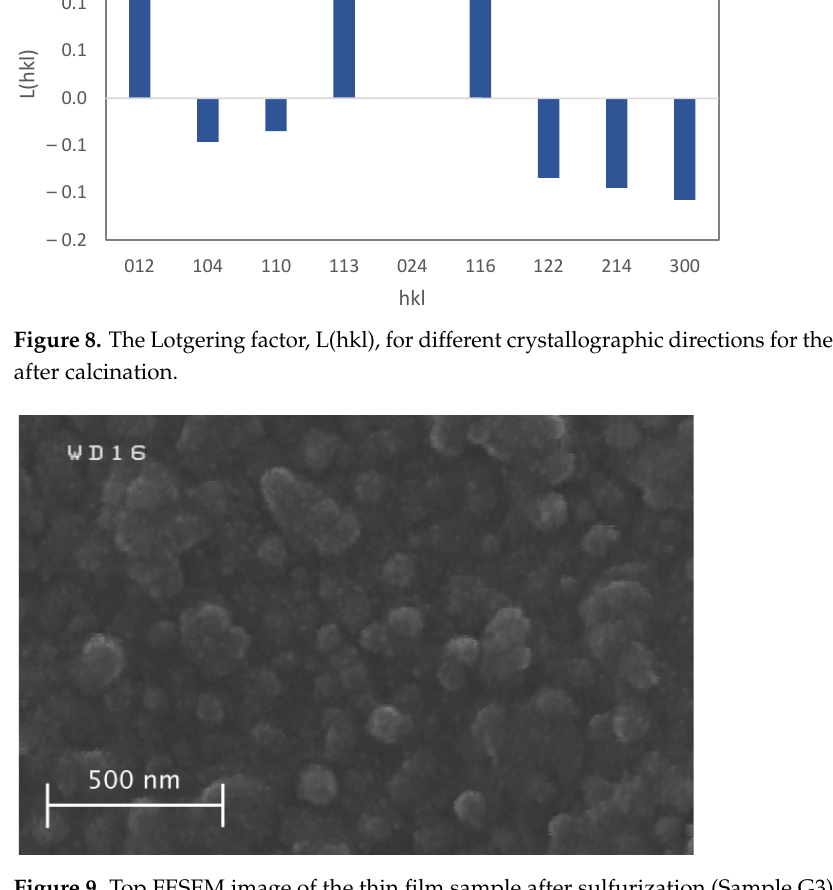
Figure 10 . The SEM Image of the cross ‐ section of pyrite thin film on FTO. The thickness of the two layers, FTO and pyrite, is compared by dashed arrows. The black arrow shows some impurities which are deposited on the surface of the thin film. Figure 11 . ( a ) The XRD pattern of pyrite powder sample with simulated patterns of reference cards of ( b ) pyrite (JCPDS 3 ‐ 065 ‐ 1211) and ( c ) hematite (JCPDS 33 ‐ 0664). (1 ̅ 11) (200) (1 ̅ 02)(2 ̅ 11)